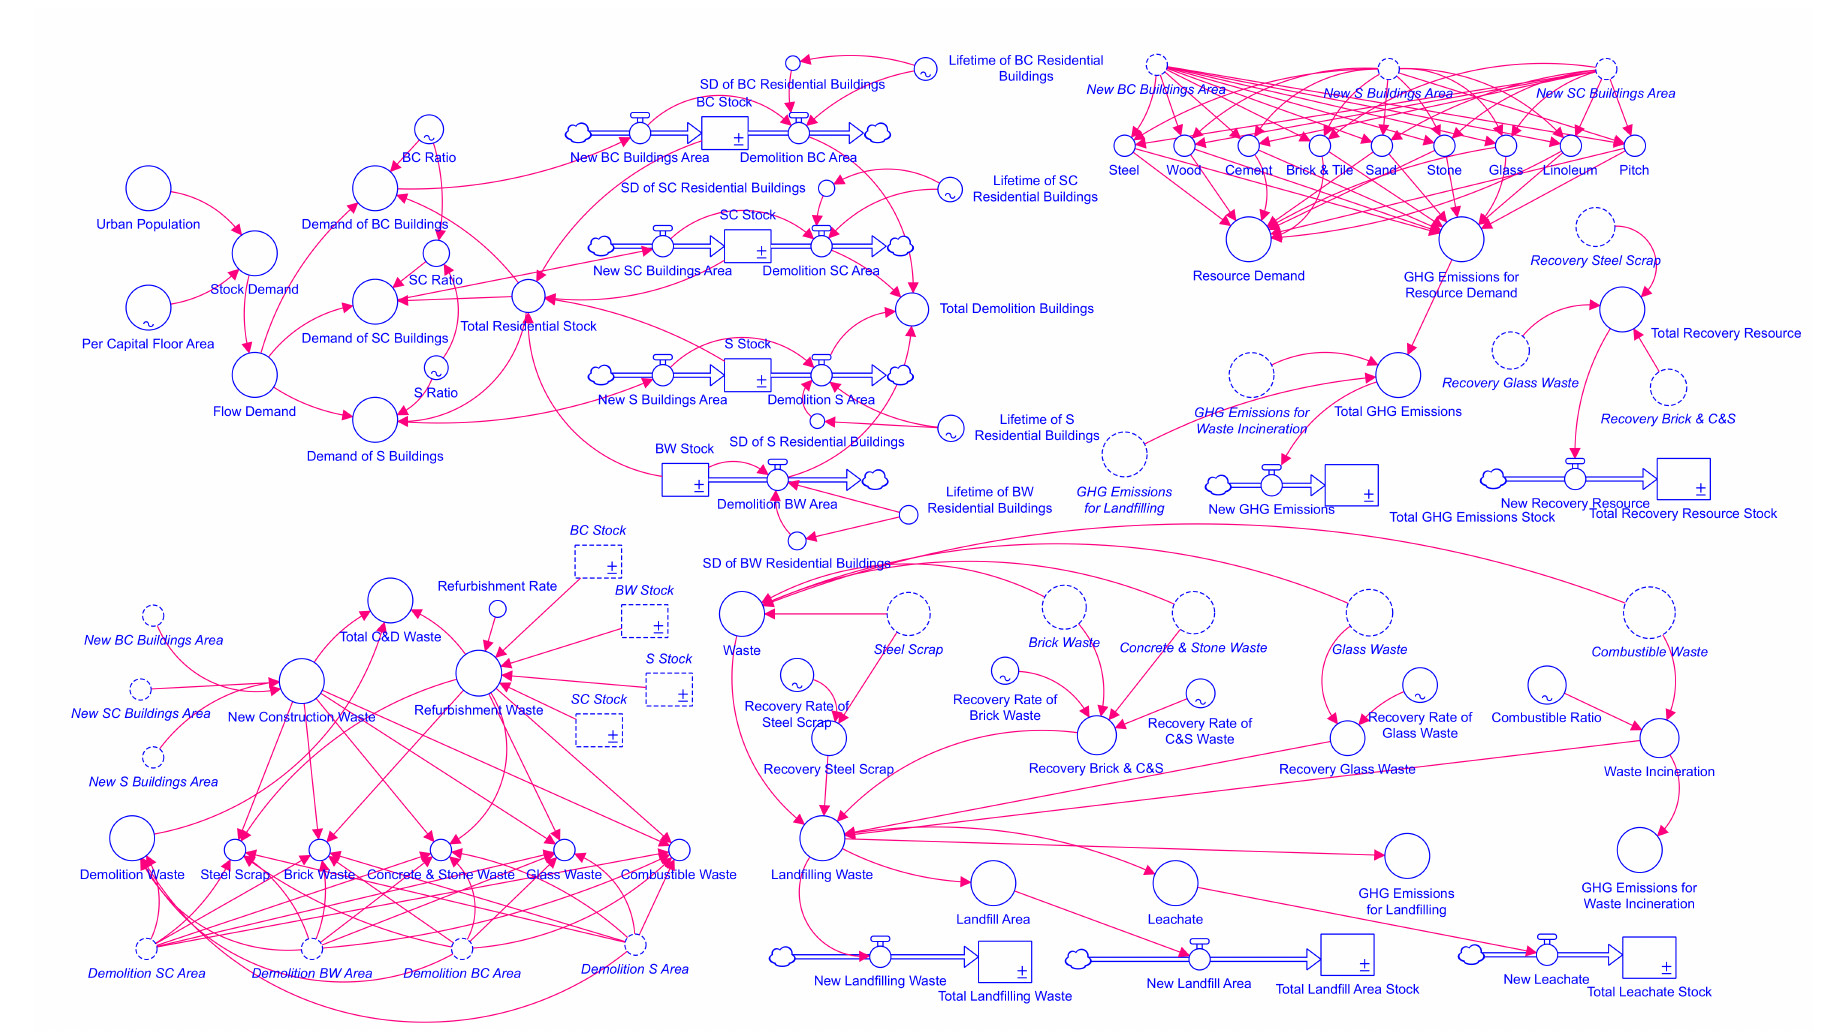
Figure 2. Stock and flow diagram of urban residential building